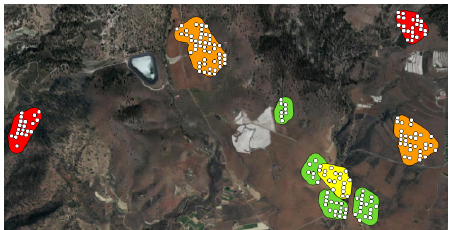
Figure 1. Sample output ADAs and the points defining these. Color coding denotes the quality of the assessment.